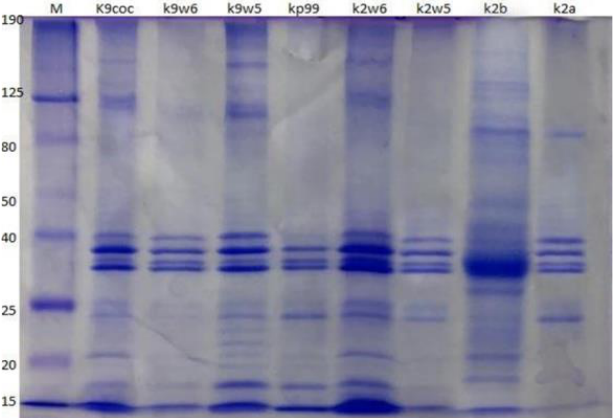
Figure 8. Bacteriophage analysis by SDS-PAGE. Samples were run on a 12% SDS-PAGE Tris-glycine gel, stained with Coomassie Brilliant Blue. The column labeled ‘M’ is a broad range protein molecular weight marker (HyperPage/Bioline). Estimated molecular masses are indicated on the left side.